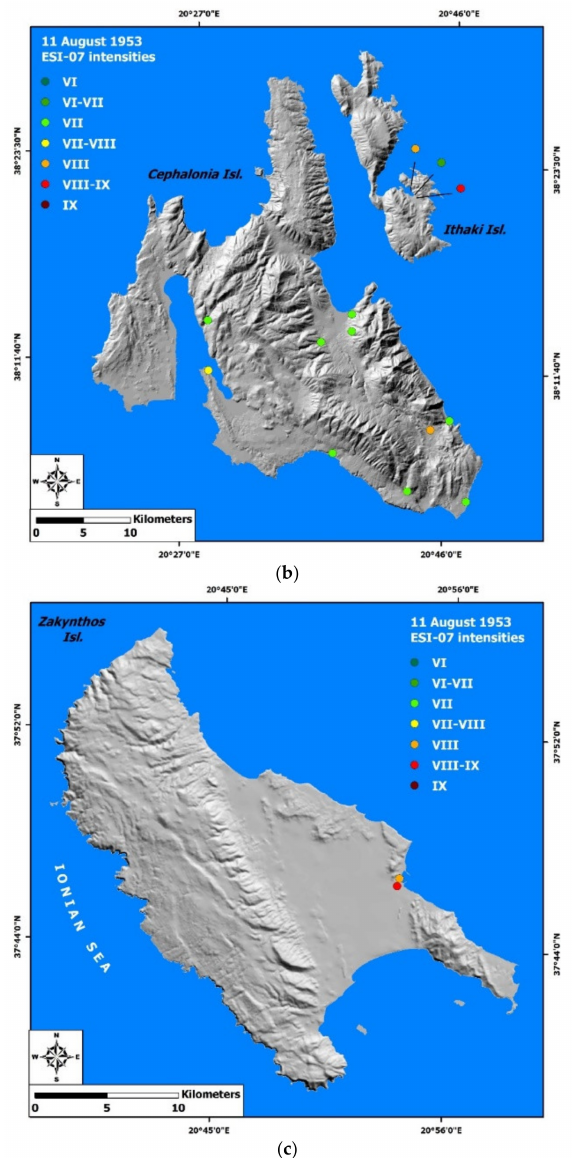
Figure 20. ESI-07 intensities for the secondary effects induced ( a ) by the 9 August 1953 earthquake in the Cephalonia and Ithaki islands and ( b , c ) by the 11 August 1953 earthquake in ( b ) Cephalonia and Ithaki as well as in ( c )